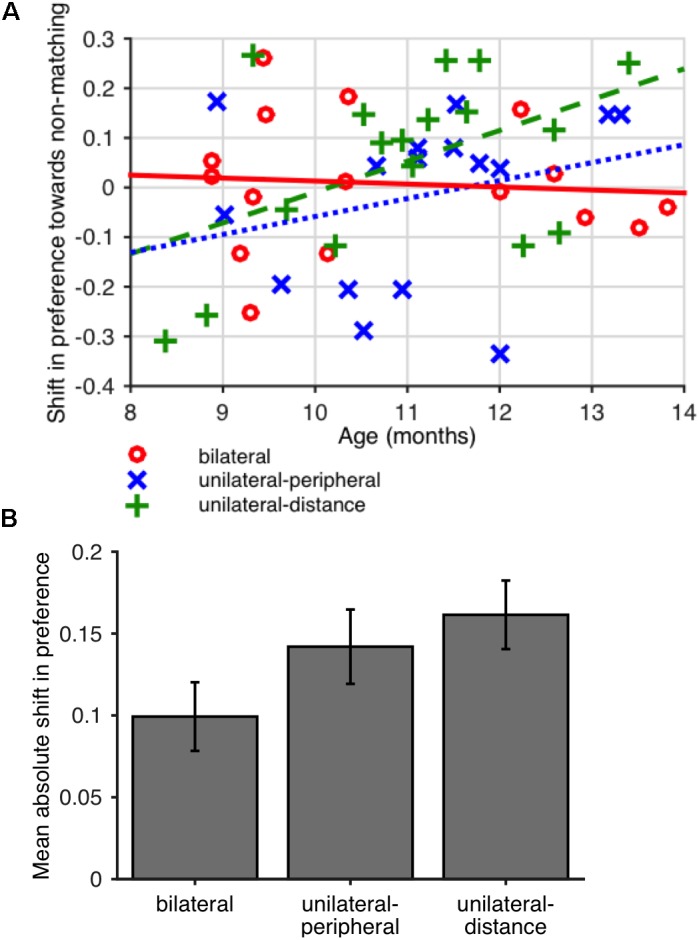
(A) Mean absolute value of the difference in preference for non-matching shapes (looking time to non-matching shape pairs divided by total looking time) between baseline and final looking time tests in Experiment 1. Error bars show SEM across participants. (B) Difference in preference for non-matching shapes between baseline and final test periods as a function of age in Experiment 1. A positive difference indicates a greater preference for non-matching shapes at final test. Lines (solid red line: bilateral; dotted blue line: unilateral-peripheral; dashed green line: unilateral-distance) show least-squares linear fits for each condition.